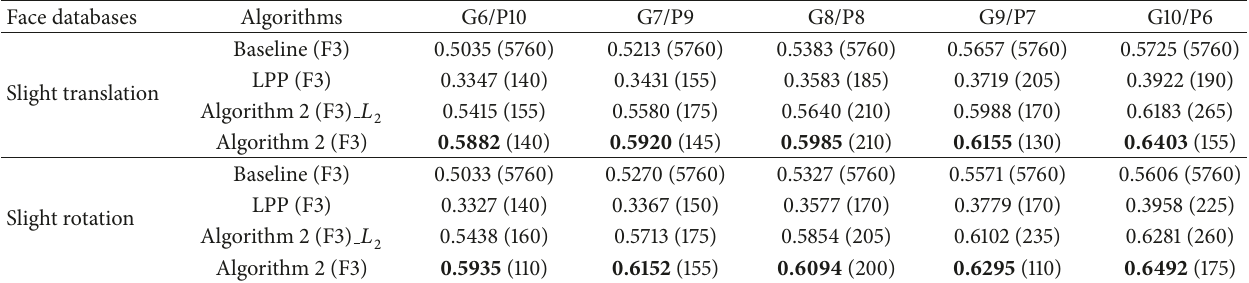
Table 27: The recognition rates on slight translation and slight rotation Extended Yale B face databases over “F3” features; recognition rates